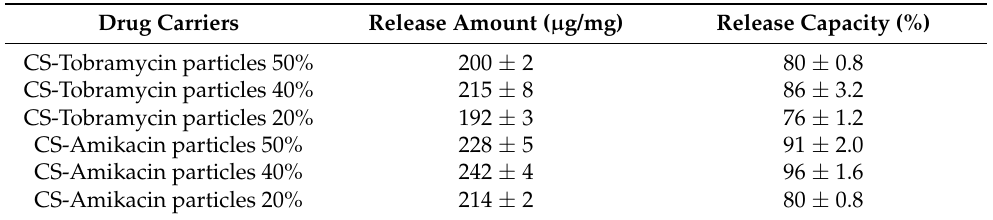
Table 2. Maximum release amount ( µ g/mg) and release capacity (%) from CS-Tobramycin and CS-Amikacin particles crosslinked at 50%, 40%, and 20% mole